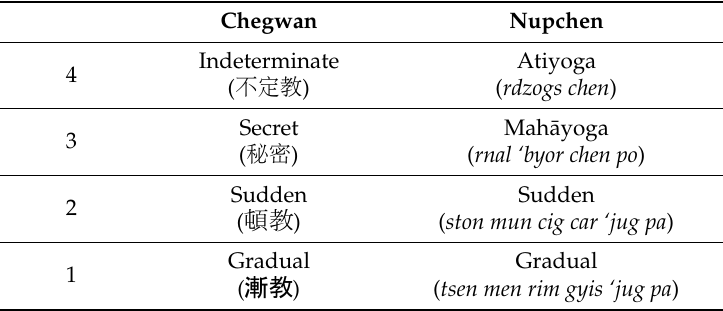
Table 1. Comparison of Chegwan and Nupchen’s fourfold classifications.